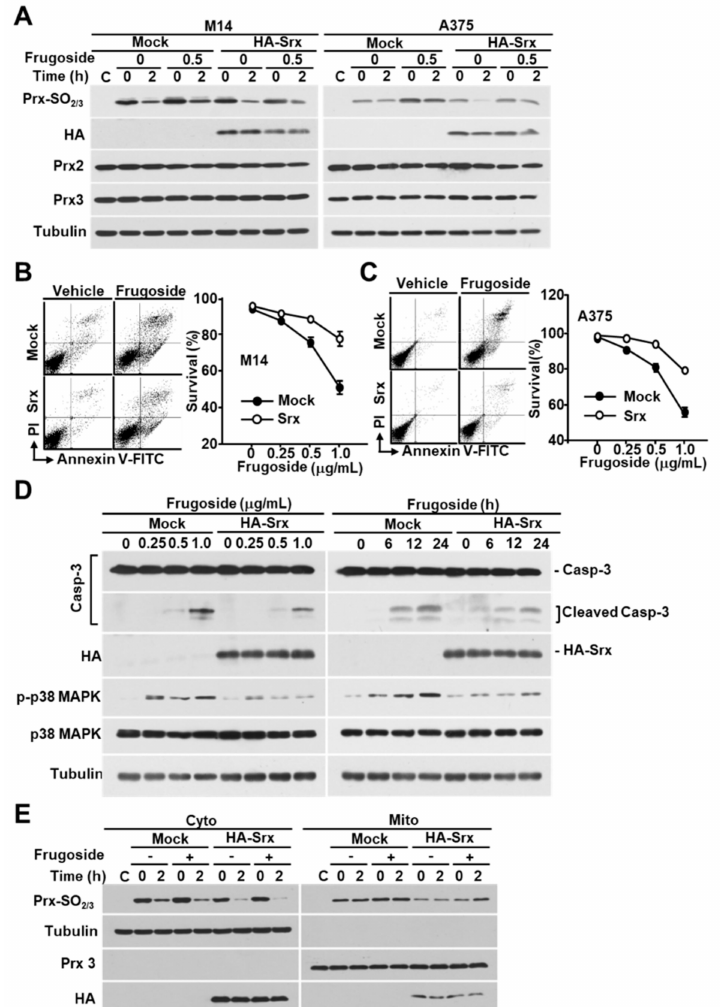
Figure 5. Srx is essential for ROS-mediated cell death by frugoside. ( A ) HA-Srx and Mock plasmids were transfected into M14 and A375 cells. After transfection for 24 h, the cells were treated with or without frugoside (0.5 µ g / mL) for 12 h, followed by H 2 O 2 treatment (200 µ M) for 10 min. H 2 O 2 was removed by replacement with a fresh medium, then the cells were incubated for the indicated times. The lysates were assessed by a western blot analysis using antibodies against the indicated proteins. ( B , C ) M14 ( B ) and A375 ( C ) cells were transfected with HA-Srx-overexpressing or Mock plasmids, and the cells were treated with various doses of frugoside. Cell death was measured by a FACS analysis after PI / Annexin V-FITC staining. ( D ) M14 cells were transfected as indicated in ( B ), and the cells were treated with frugoside in dose- and time-dependent manners. The cell lysates were subjected to western blotting with specific antibodies for caspase-3, HA, phospho-p38, p38, and tubulin. ( E ) Srx-overexpressed M14 cells were treated with frugoside and H 2 O 2 , as described in ( A ), and the cells were separated into cytosolic and mitochondrial fractions. The fractionated lysates were subjected to western blotting with antibodies specific to Prx-SO 2 , Prx3, and